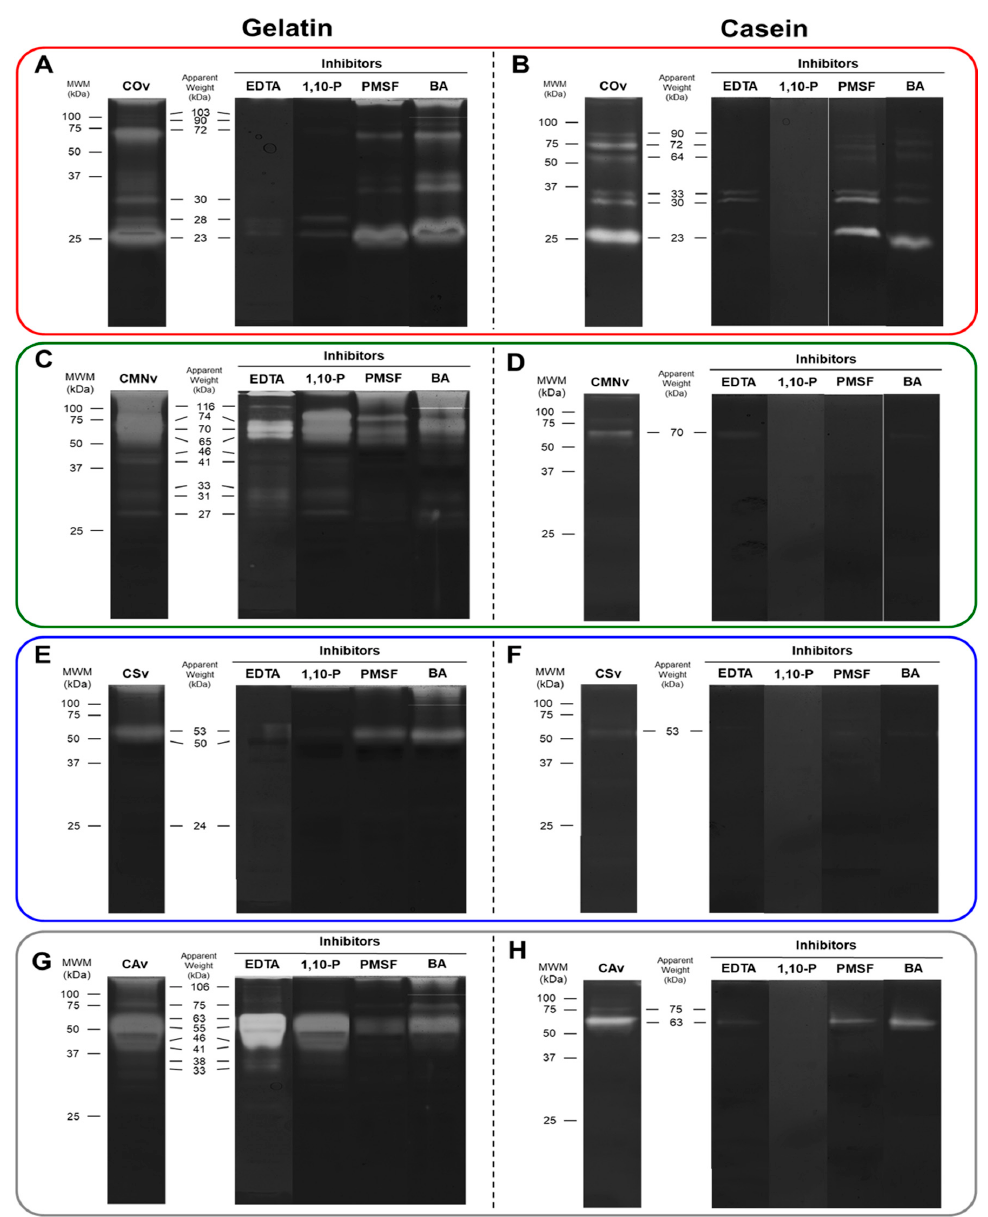
Figure 3. In-gel zymography for proteases of venoms and their inhibitors. 8 µg of ( A, B ) C. ornatus (red box), ( C, D ) C. m. nigrescens (green box), ( E, F ) C. scutulatus (blue box), and ( G, H ) C. atrox (gray box) venoms were separated on a 12% SDS-PAGE copolymerized with 1% ( w/v ) gelatin ( A, C, E, G ) or casein ( B, D, F, H ). Each venom protease activity was tested versus 5 mM protease inhibitors: EDTA, 1,10-P, PMSF, and BA. As a control for each sample, the venom was incubated with no inhibitor. Apparent molecular weights (kDa) for the bands were computed with a GelAnalyzer and are denoted in the figure for each venom.